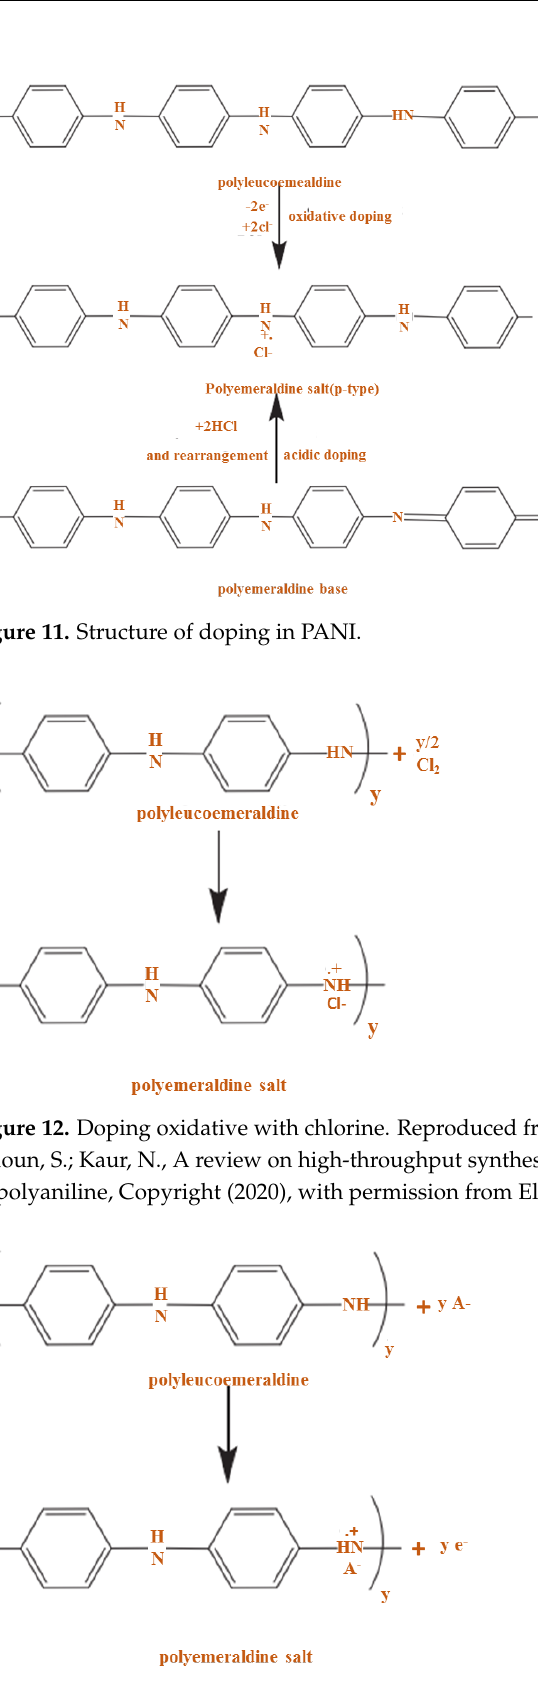
Figure 13. Doping electrochemical of polyleucoemeraldine. Reproduced from Eur. Polym. J., 125, Kumari Jangid, N.; Jadoun, S.; Kaur, N., A review on high-throughput synthesis, deposition of thin films, and properties of polyaniline, Copyright (2020), with permission from Elsevier.